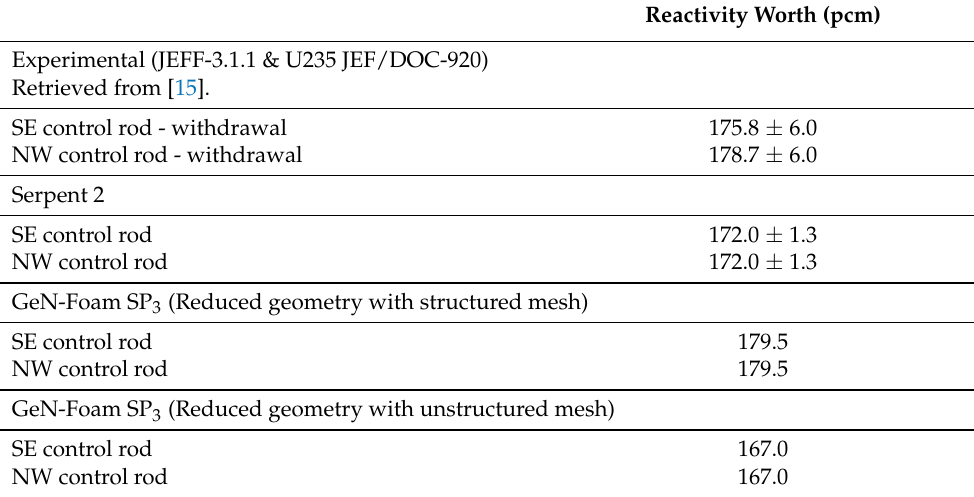
Table 2. Experimental control rod reactivity worth compared to Serpent and